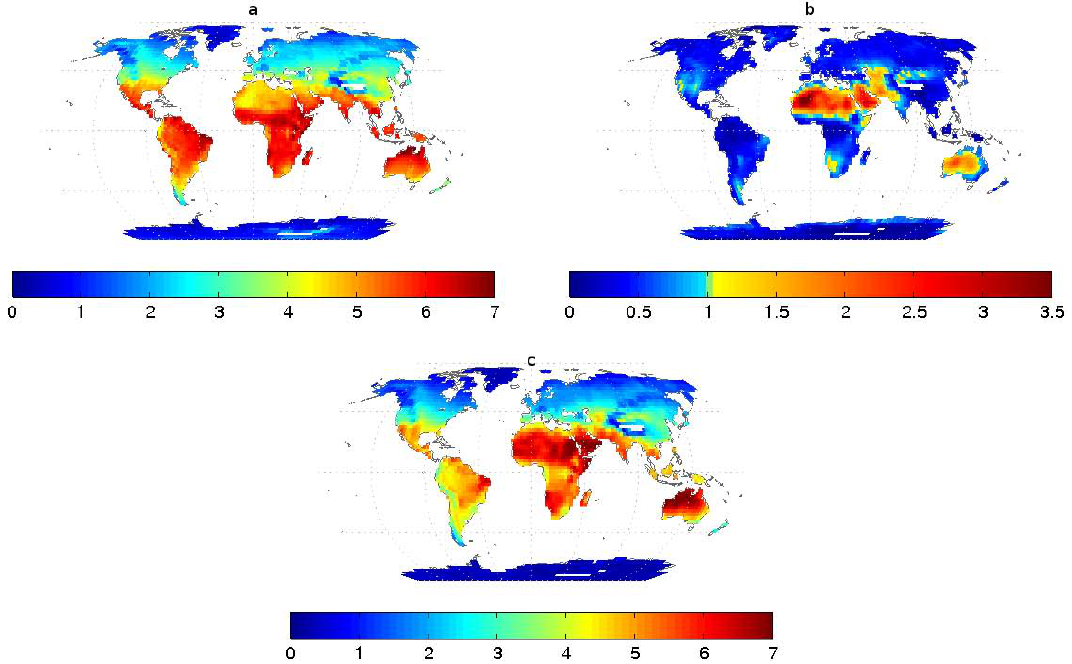
Fig. 2. Long-term averages (July 1983–June 2002). Top left: energy balance evaporation rate E r (mmday − 1 ) computed by radiation transfer models. Top right: ratio E a /E r . Bottom: Penman evaporation rate E p (mmday − 1 ), as a weighted average of E r and E a .